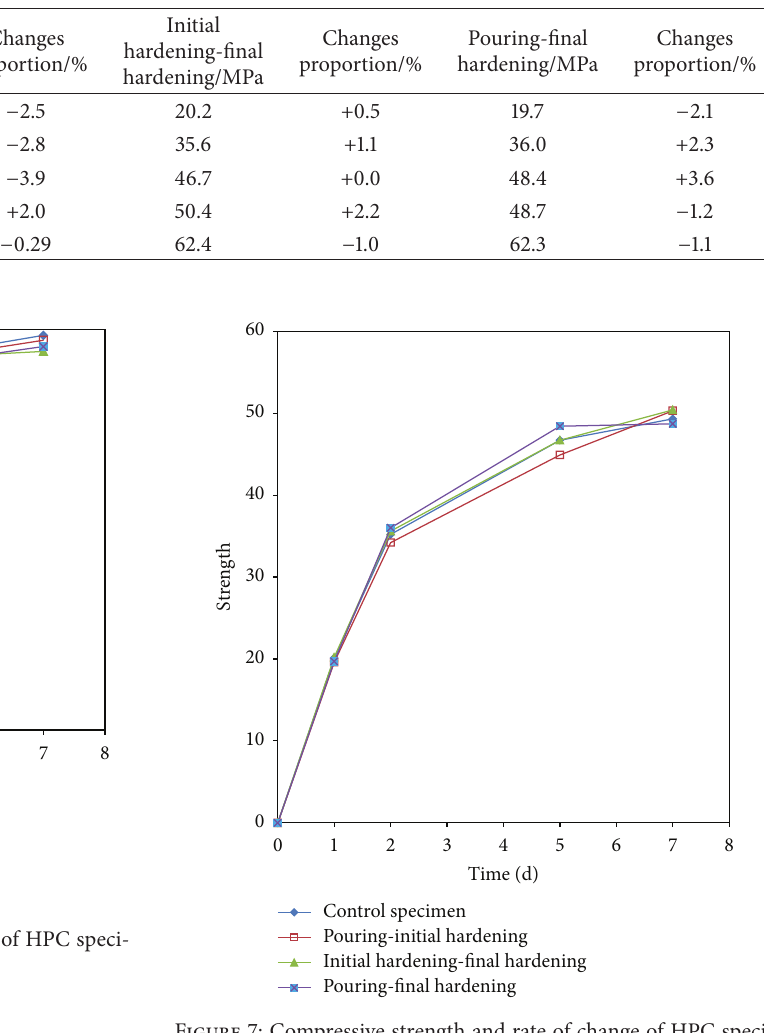
Table 4: Compressive strength and rate of change of HPC specimens with vibration parameters of 4 Hz and 1mm.